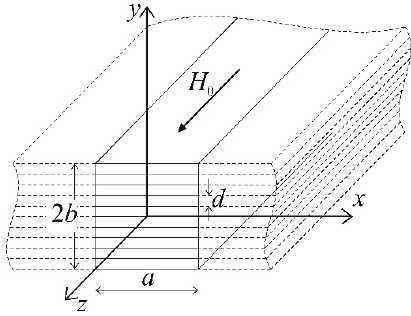
Figure 7. A model of a laminated core with infinite x , z dimensions.